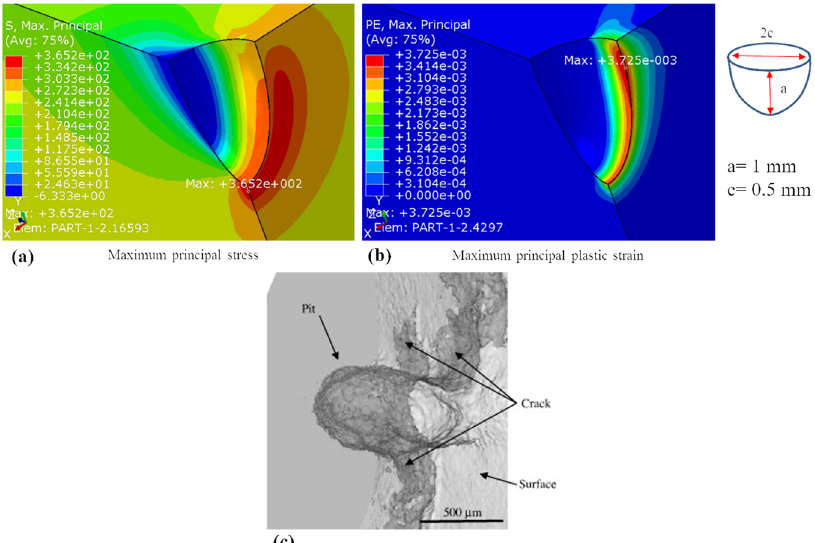
Fig. 2 Stress concentration at corrosion pit and the pit-to-crack transition. a Maximum principle stress and b maximum principle strain distribution for a semi-ellipsoidal pit in the canister. The pitting area in the canister is enlarged to clearly show the distribution. c The initiation of cracks in the region close to pit mouth. Images in a and b were calculated by our FEA model, while c was taken from ref. 35 . Reproduced with permission from ref. 35 , copyright (Elsevier,